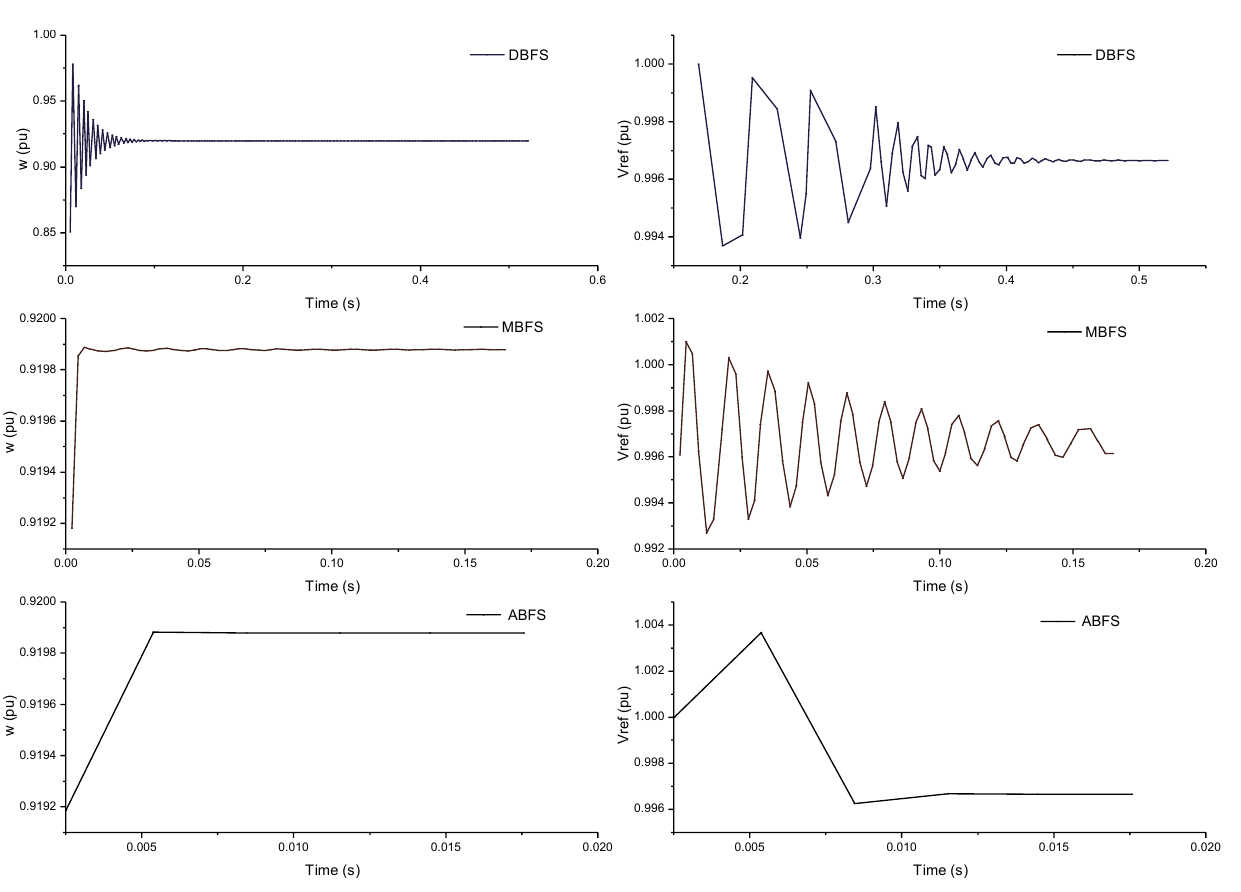
Figure 3. Convergence of the solution with respect to computation